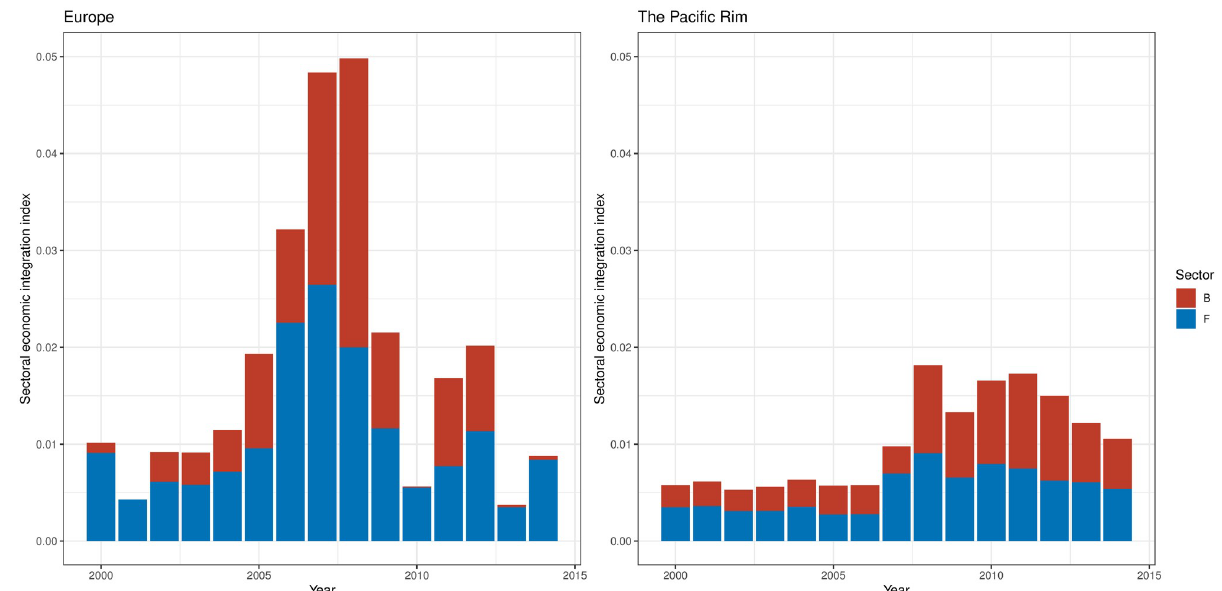
Fig 9. Sectoral economic integration index of mining and quarrying, and construction in two regional communities. B: mining and quarrying, F: construction.